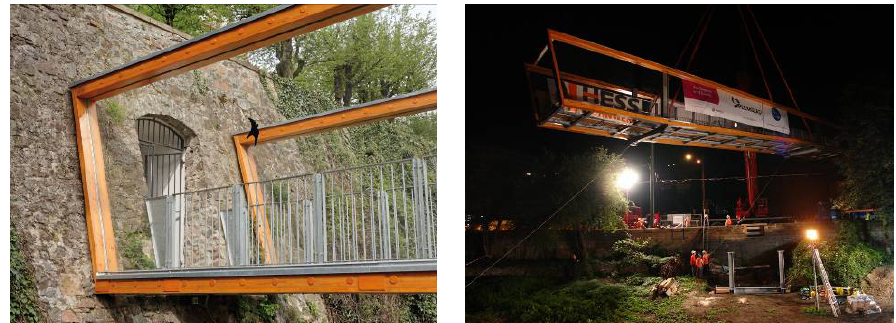
Figure 12a: Clearance between bridge and existing building, b: Bridge